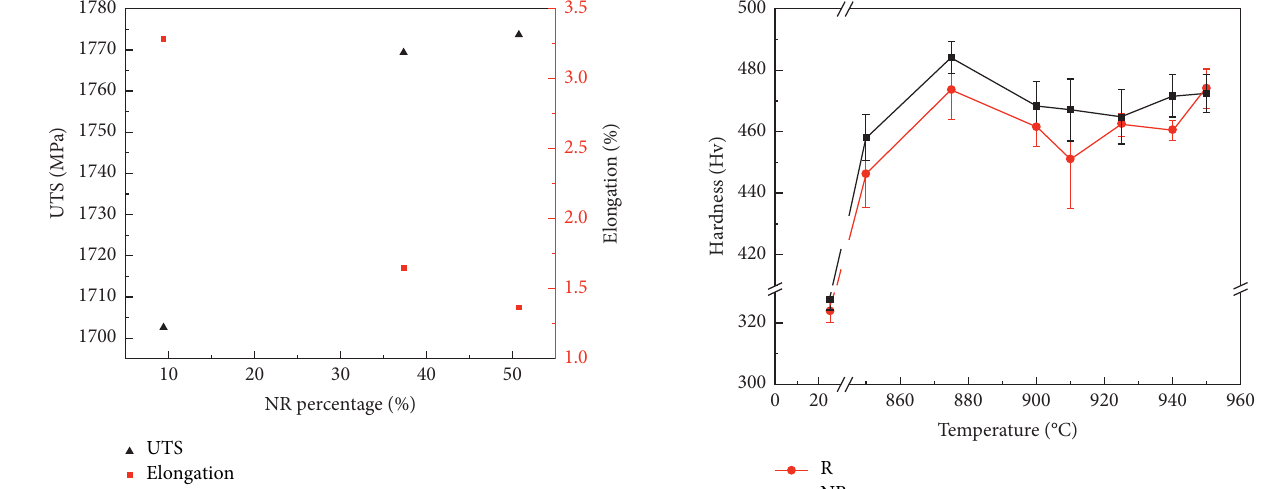
Figure 12: The relationship between tensile properties and NR percentage of specimens rapidly heated to 875 ° C followed by ageing.